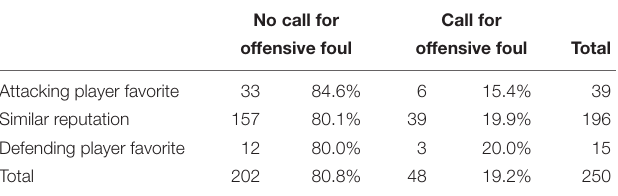
TABLE 3 | Frequency of calls for an offensive foul by the players’ reputation differences.